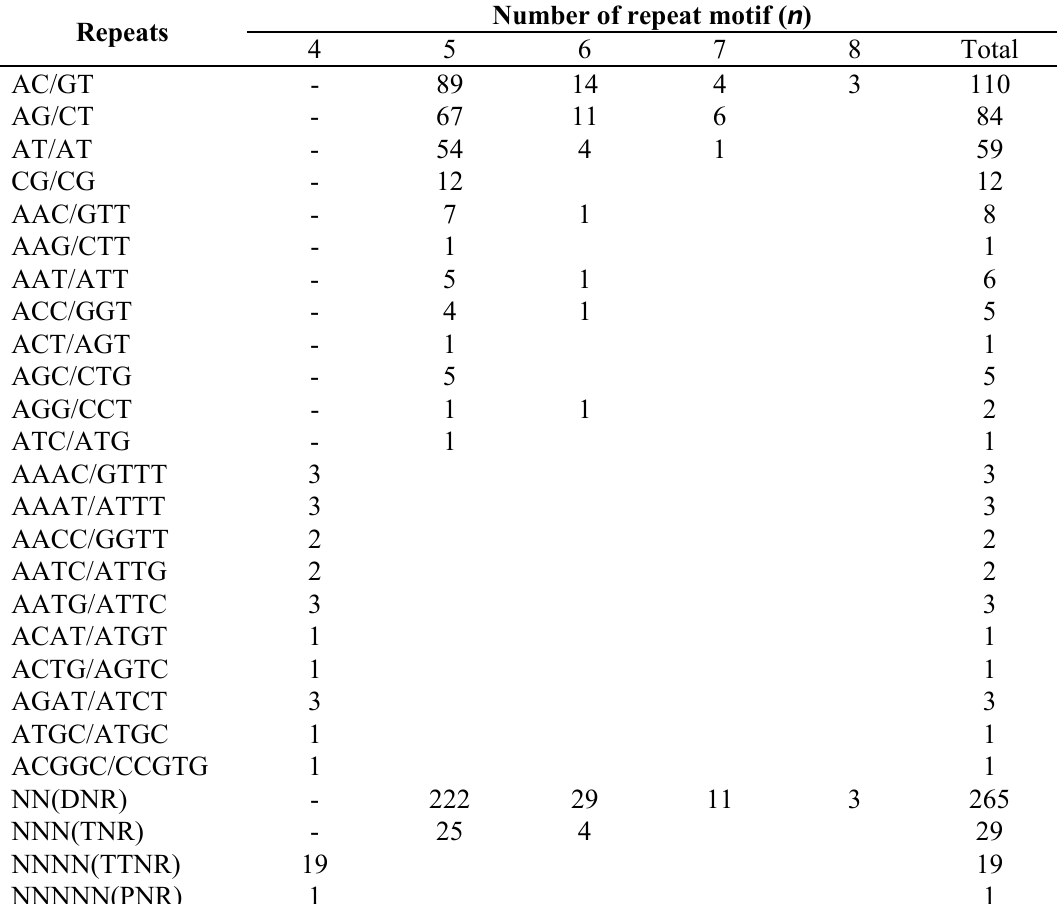
Table 1. Frequency and distribution of SSRs in the analyzed Frankliniella occidentalis